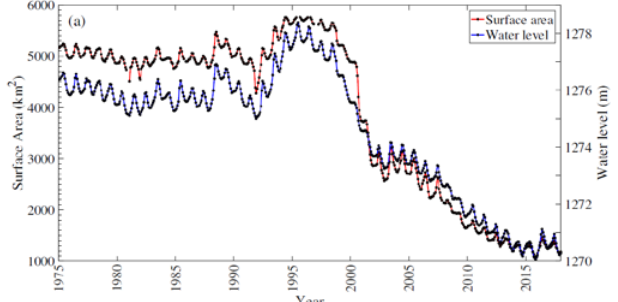
Figure 2 Variations of surface area and water level height of the Urmia Lake from 1975 to